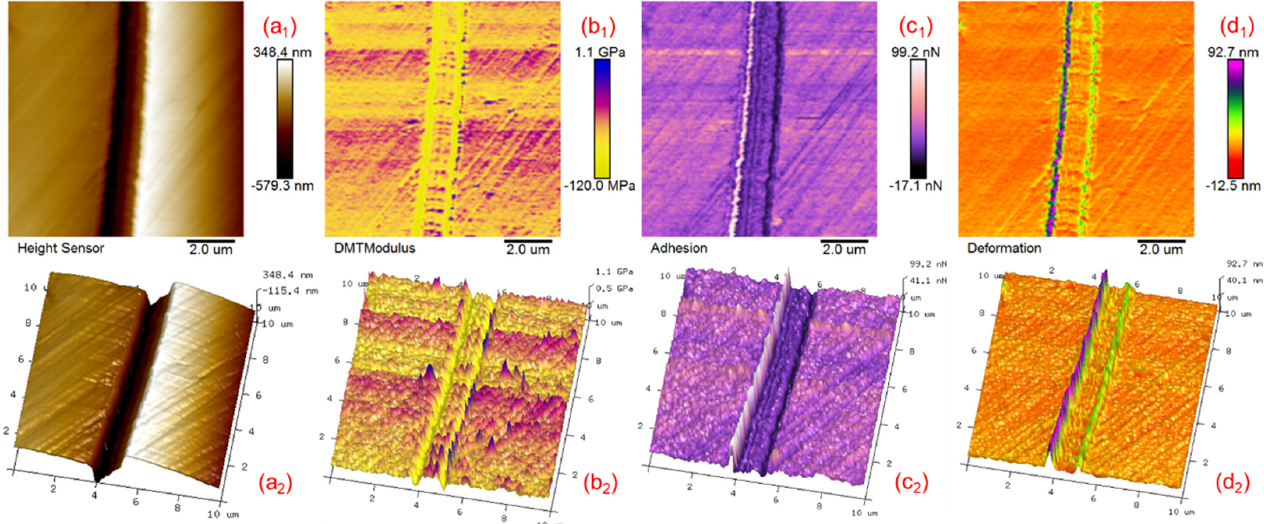
Figure 7. Characterization of micro mechanical properties: ( a 1 ) 2D surface morphology; ( b 1 ) 2D elastic modulus; ( c 1 ) 2D adhesion; ( d 1 ) 2D deformation; ( a 2 ) 3D surface morphology; ( b 2 ) 3D elastic modulus; ( c 2 ) 3D adhesion; ( d 2 ) 3D deformation.